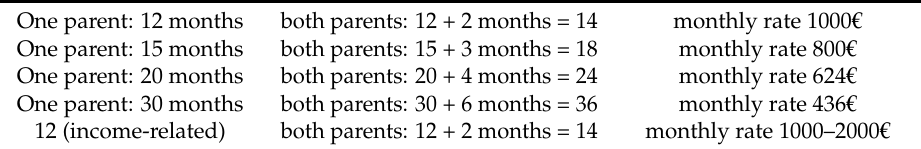
Table 1. Austria’s Parental Leave System since 2000, including 5 forms of childcare allowance from 2000 to February 2017 (for parents of newborn, adopted or foster